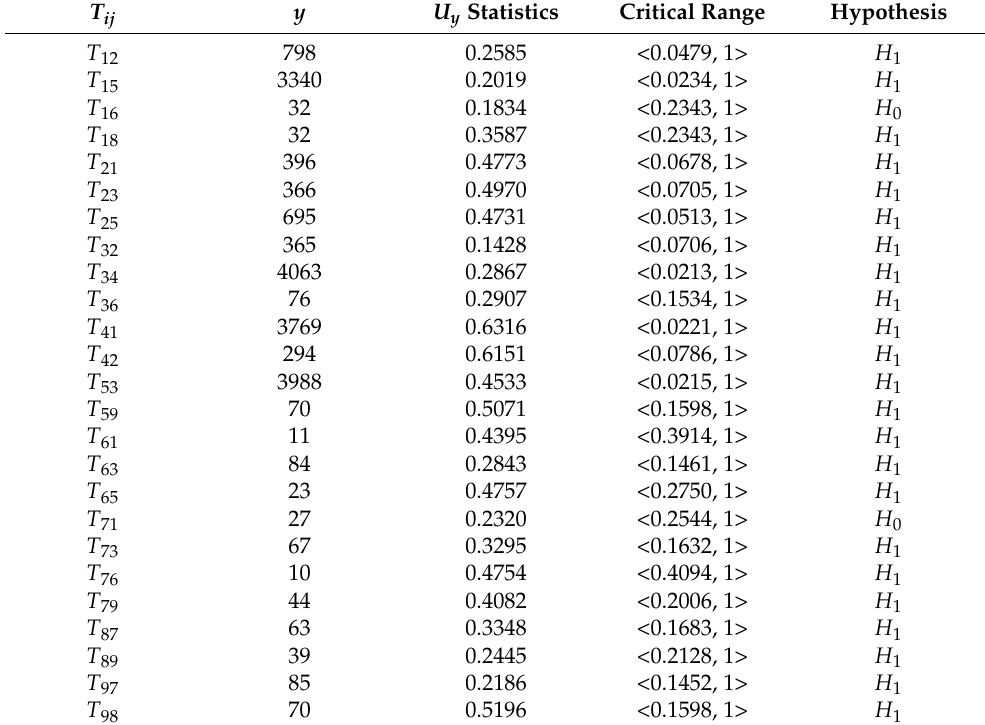
Table 4. Results of Kolmogorov